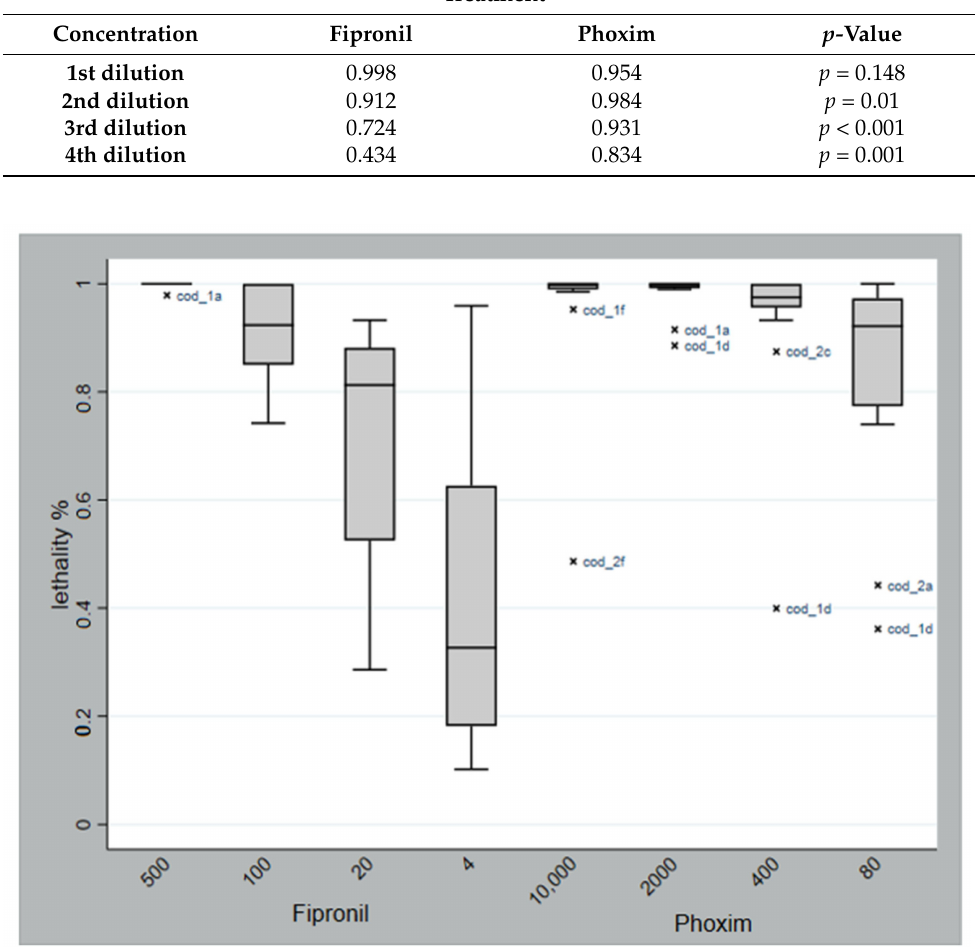
Figure 2. Boxplot of the average lethality for the mites coming from the different farms at different treatment concentration (ppm) for the two tested products. x cod_outliers representing farms considered as potential critical farms for the presence of a lower efficacy of